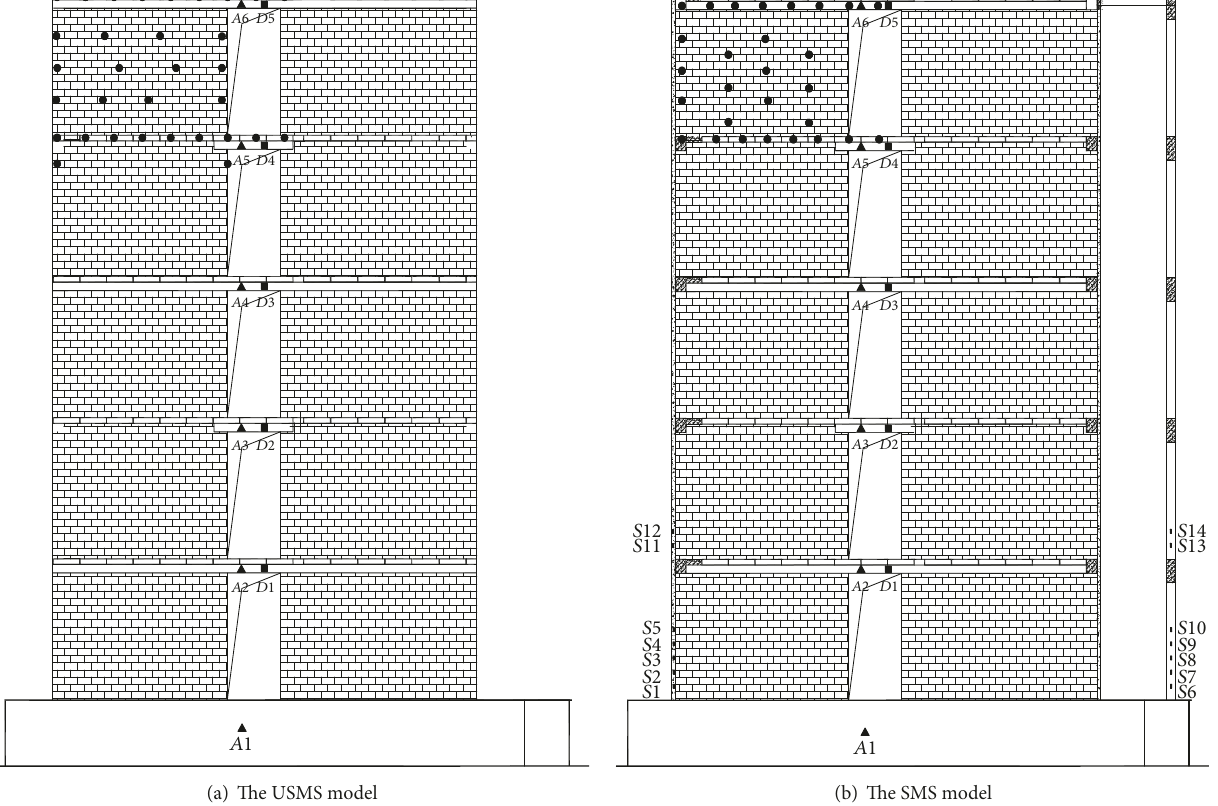
Figure 5: Instrumentation arrangement of the models, in which the triangle points denote the accelerometers, the square points denote displacement meters, the circle points denote 3D dynamic target points, and the rectangle points denote strain